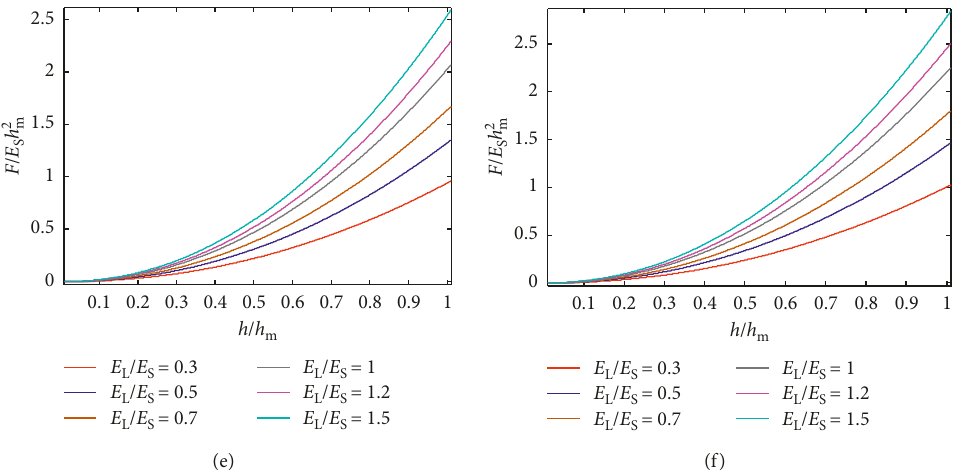
Figure 4: Loading versus depth curves of different E (e) E L / E S � 1.2. (f) E L / E S �